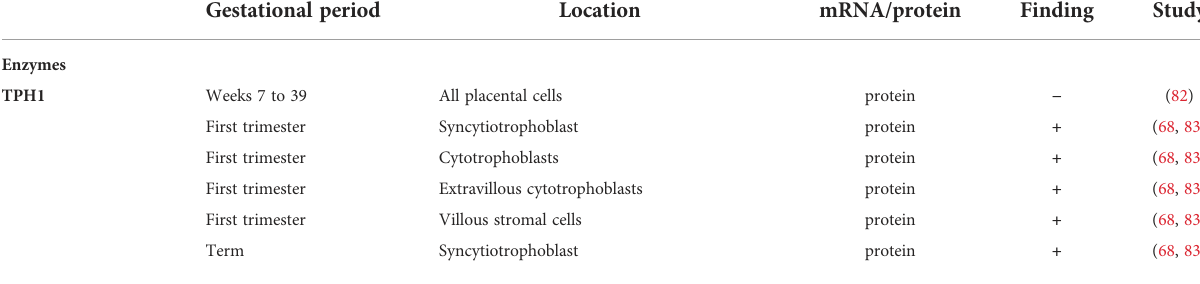
TABLE 2 Results on the localization of mRNAs and proteins of serotonin-related genes in human placenta obtained by in situ hybridization (ISH) and by immunohistochemical analysis (ISH), respectively. Gestational